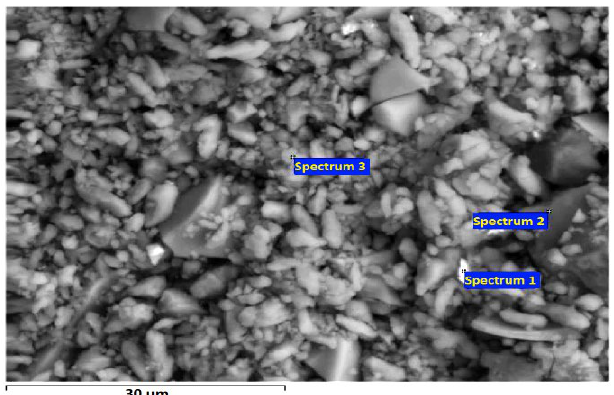
Figure 2. Electron microscopic image of the sorbent before wastewater treatment. Table 3. Composition of the sorbent before wastewater treatment.